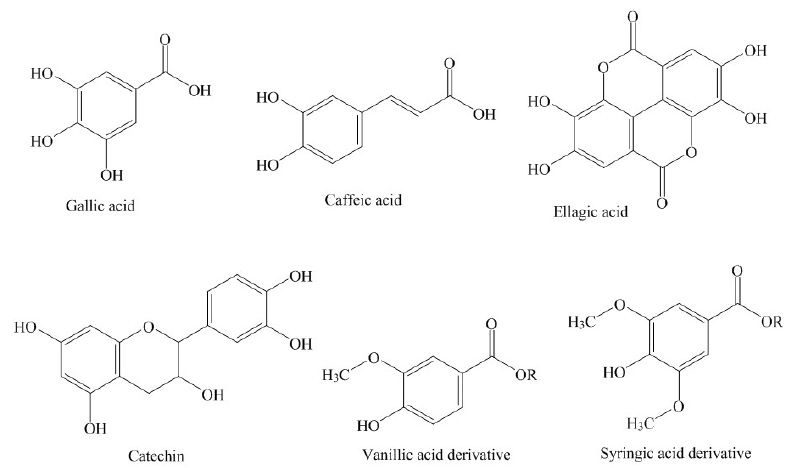
Figure 2. Structure of the major identified phenolic compounds. The R group represents the possible derivative of identified phenolic moiety.